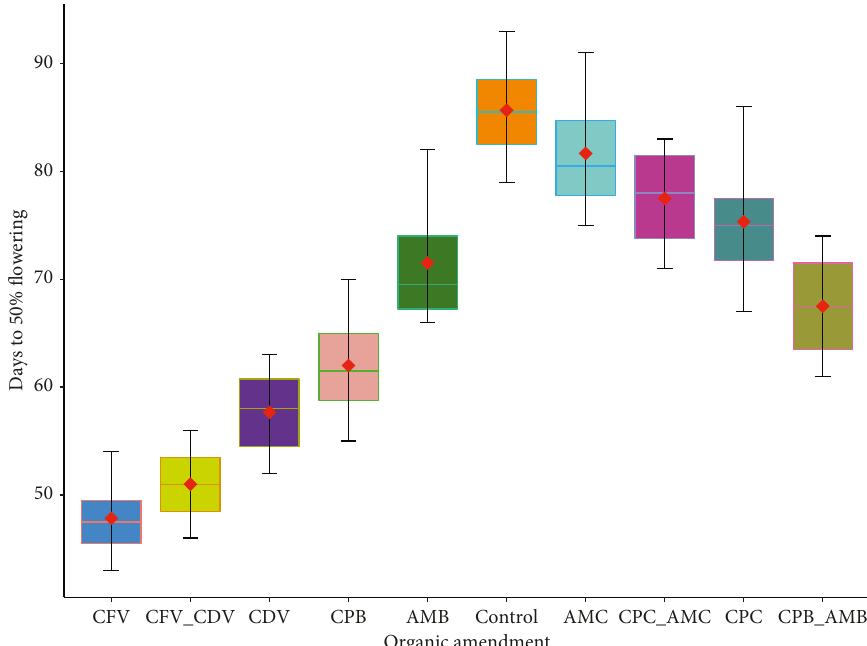
Figure 6: Days to 50% flowering in different organic